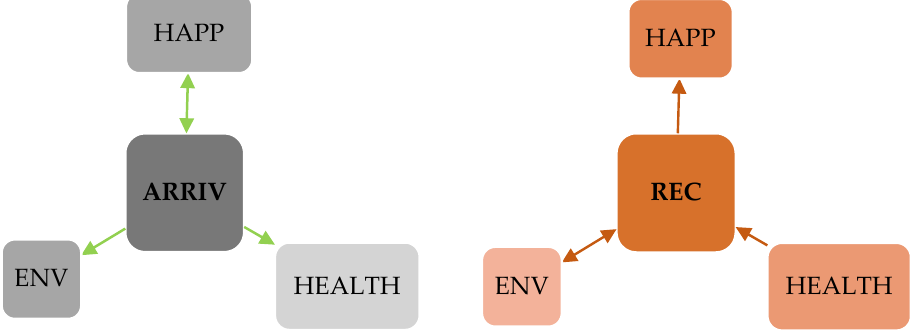
Figure 1. Results for Dumitrescu and Hurlin panel causality test. Source: own computations using EViews 12.